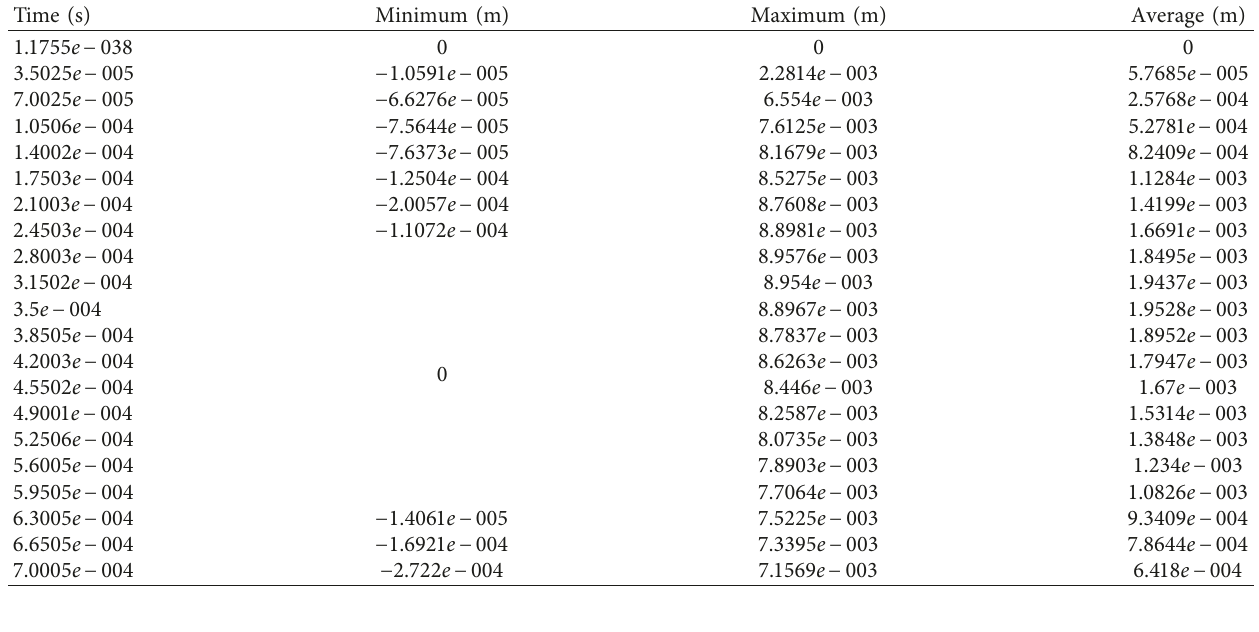
Table 7: Directional deformation in Z direction of steel layer of sample 1 during the time of simulation. Time (s)